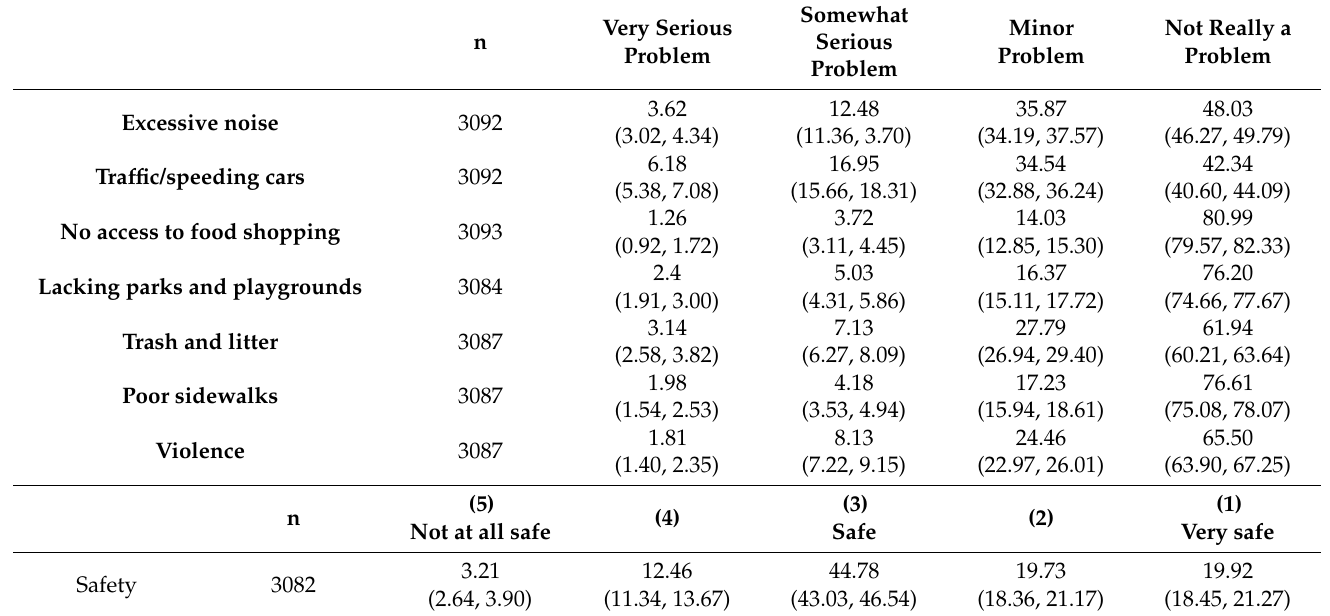
Table 2. Perceptions of the neighborhood environment at baseline expressed in frequencies (95%